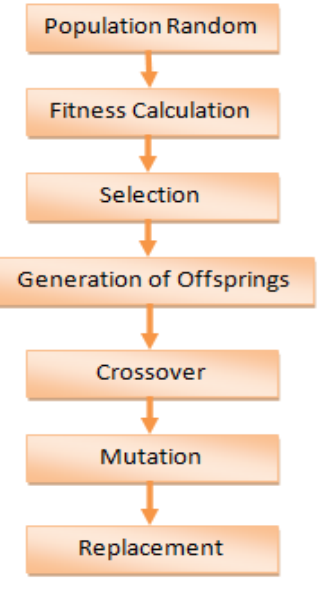
Figure 4. Flowchart of Updated GA.